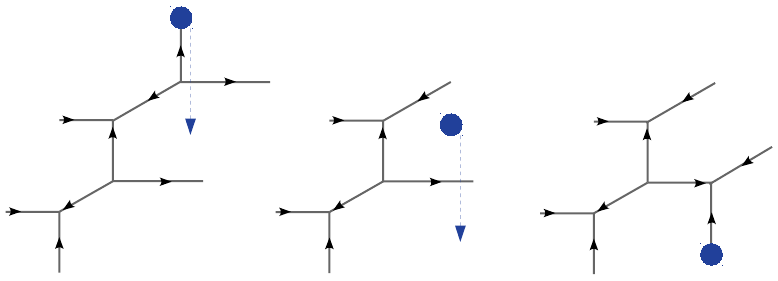
Figure 12 . Starting with the strip geometry, the T 2 geometry can be obtained via two successive Hanany-Witten moves. The blue dot represents the 7-brane on which the 5-branes